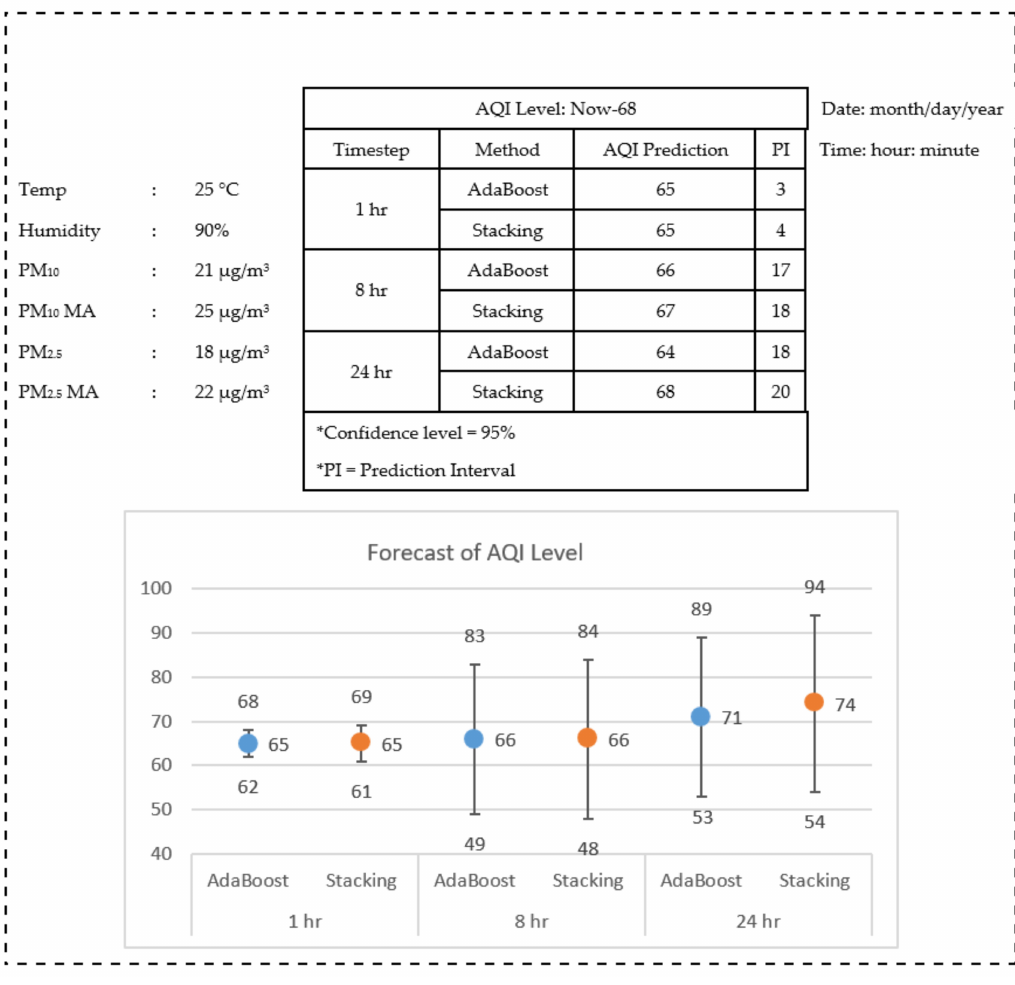
Figure 9. Illustration of Air Quality Monitoring and Forecasting